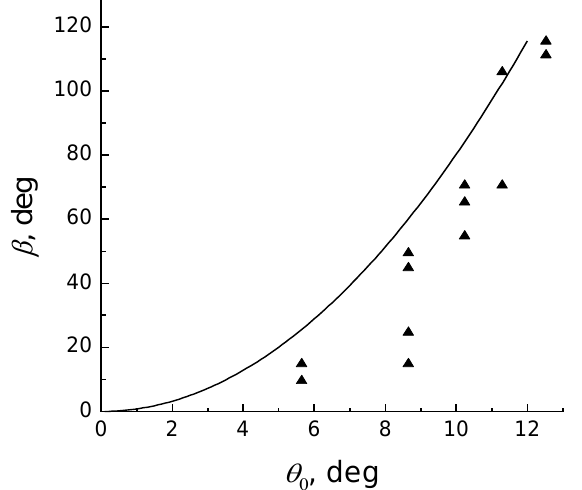
Figure 6. Dependence of the rotation angle of the polarization plane on the tilt angle of the beam relative to the axis of an optical fiber of length 7.5 cm; theoretical (solid curve) and experimental [13] values (triangles).